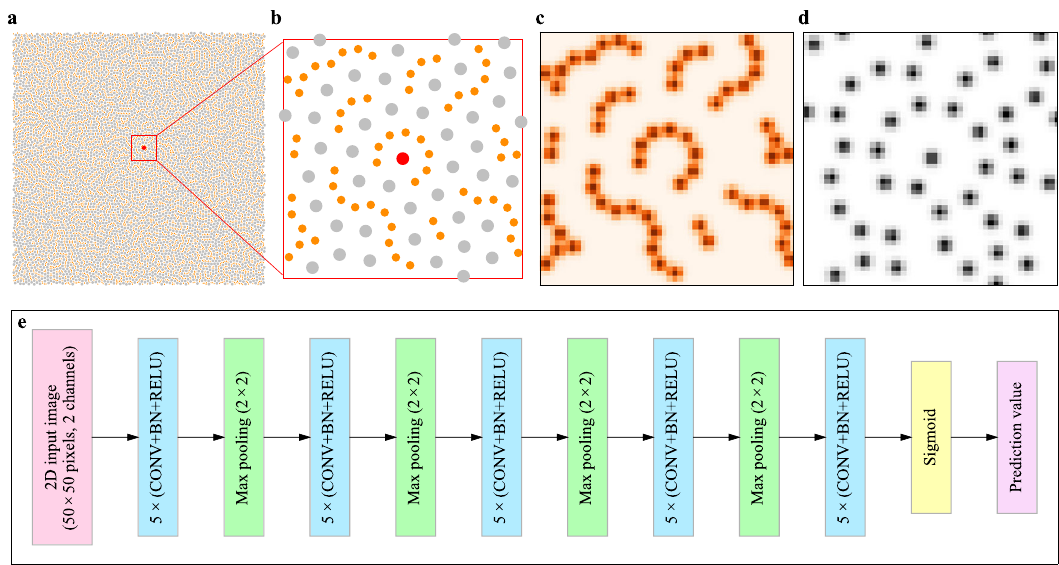
Fig. 1 Atomic structure representation and model architecture for 2D glasses. a Snapshot of a 2D model glass. Orange and silver circles represent small ( S ) and large ( L ) particles, respectively. b A close-up showing a local con fi guration around the red particle in a . c , d Corresponding spatial density map (SDM) of the S and L particles, respectively. e Architecture of the convolutional neural network (CNN) model used for 2D glasses, which contains 25 (5 in each blue box) 2D convolutional (conv.) layers. A 2D max-pooling layer is periodically inserted in between the successive convolutional layers. The last convolutional layer is followed by the output layer which is a sigmoid neuron. The corresponding architecture of the CNN model for our 3D model glasses is shown in Supplementary Fig.